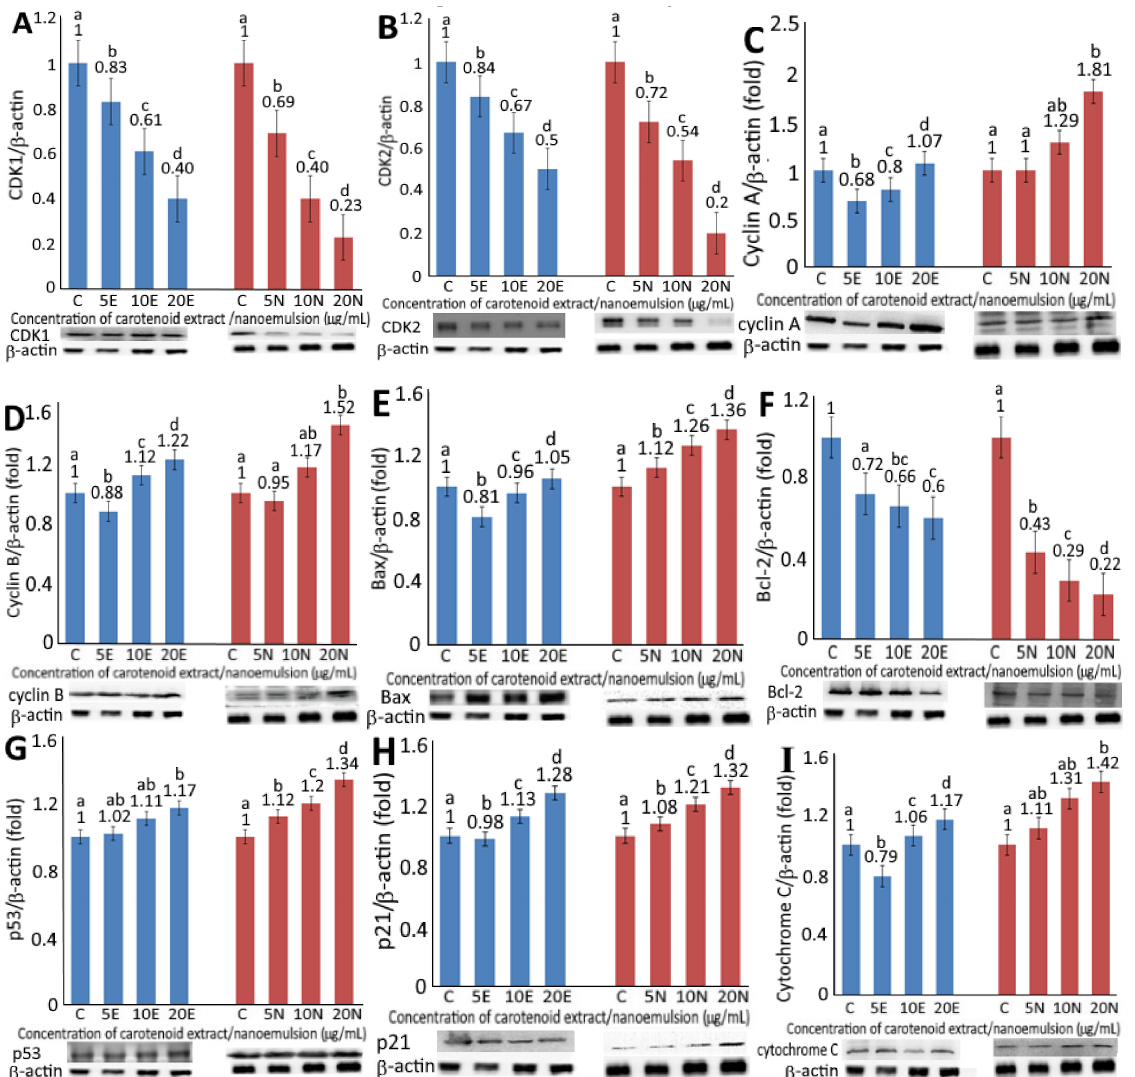
Figure 4. Levels of protein expressions for CDK1 ( A ), CDK2 ( B ), cyclin A ( C) , cyclin B ( D ), Bax ( E ), BCL2 ( F ), p53 ( G ), p21 ( H ) and cytochrome C ( I ) as affected by carotenoid extract and nanoemulsion. For control, cells were incubated with medium only. Data are represented as mean ± standard deviation of triplicate determinations, with different small letters (a–d) denoting significantly different values at p <